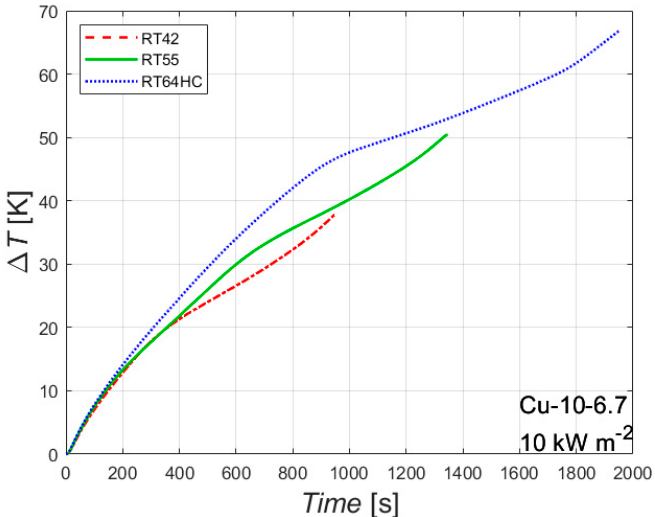
Figure 6. Effect of melting temperature on the difference between wall and initial temperatures for the 10 PPI copper foam with a porosity of 0.933 with an imposed heat flux of 10 kW m − 2 . The melting temperature affects both the time needed to completely melt the PCM and the temperature of the heated side at the end of the melting process. The lower the